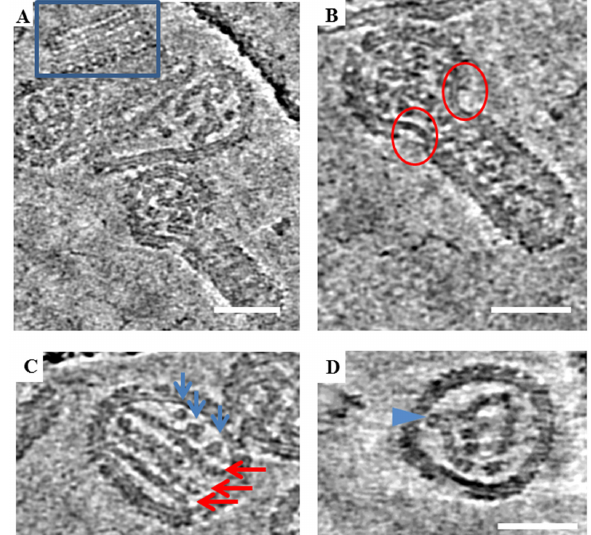
Figure 5. Tomographic slices showing various structural features of ANDV. ( A ). Regions boxed in blue are different slices through a tomogram showing locally ordered arrays of spikes on ANDV particles. ( B ). Regions marked by red circles show bare patches devoid of spikes on a particle with irregular morphology. Bare patches were observed to occur at the “neck” where round and tubular portions of irregular particles meet. ( C ). Representative image of parallel RNP rods in ANDV particles in a tomogram slice (red arrows) and additional densities, likely. Blue arrows point to cross sectional views through additional RNP segments. ( D ). Curved and bent RNP segment. Legend: Blue arrow indicates a point of projection and possible attachment of the RNP to the cytoplasmic domain of the transmembrane glycoprotein. Scale bars = 100 nm.